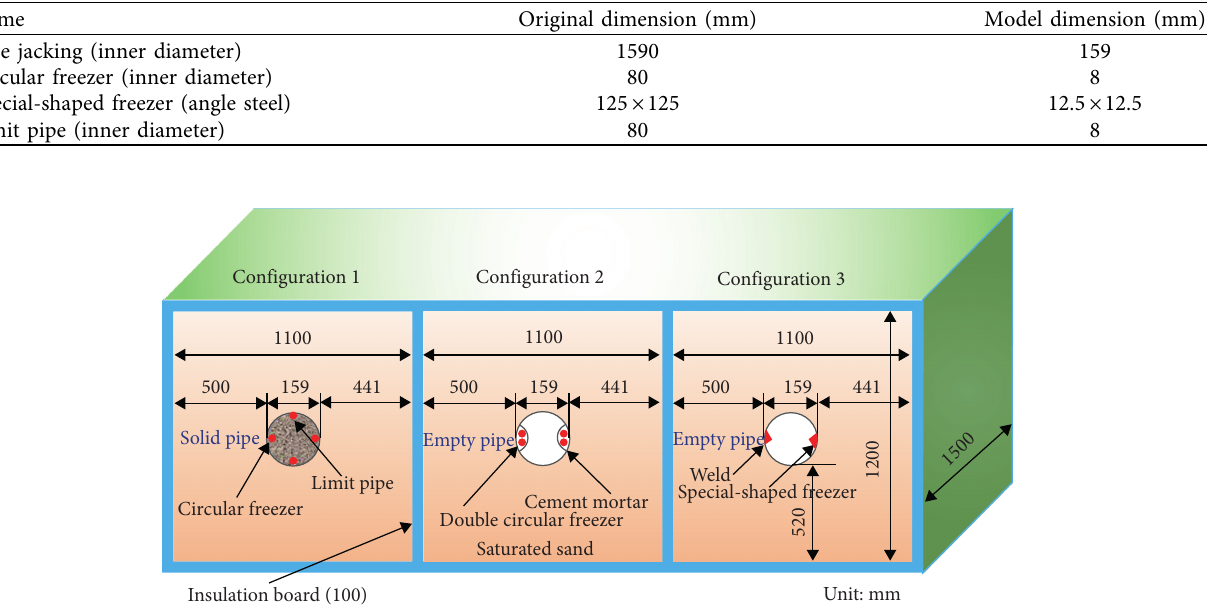
Figure 3: Schematic diagram of model box.